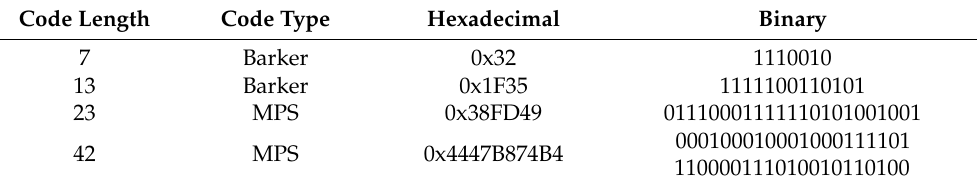
Table 2. Codes used in the experiment of VEAP waveform